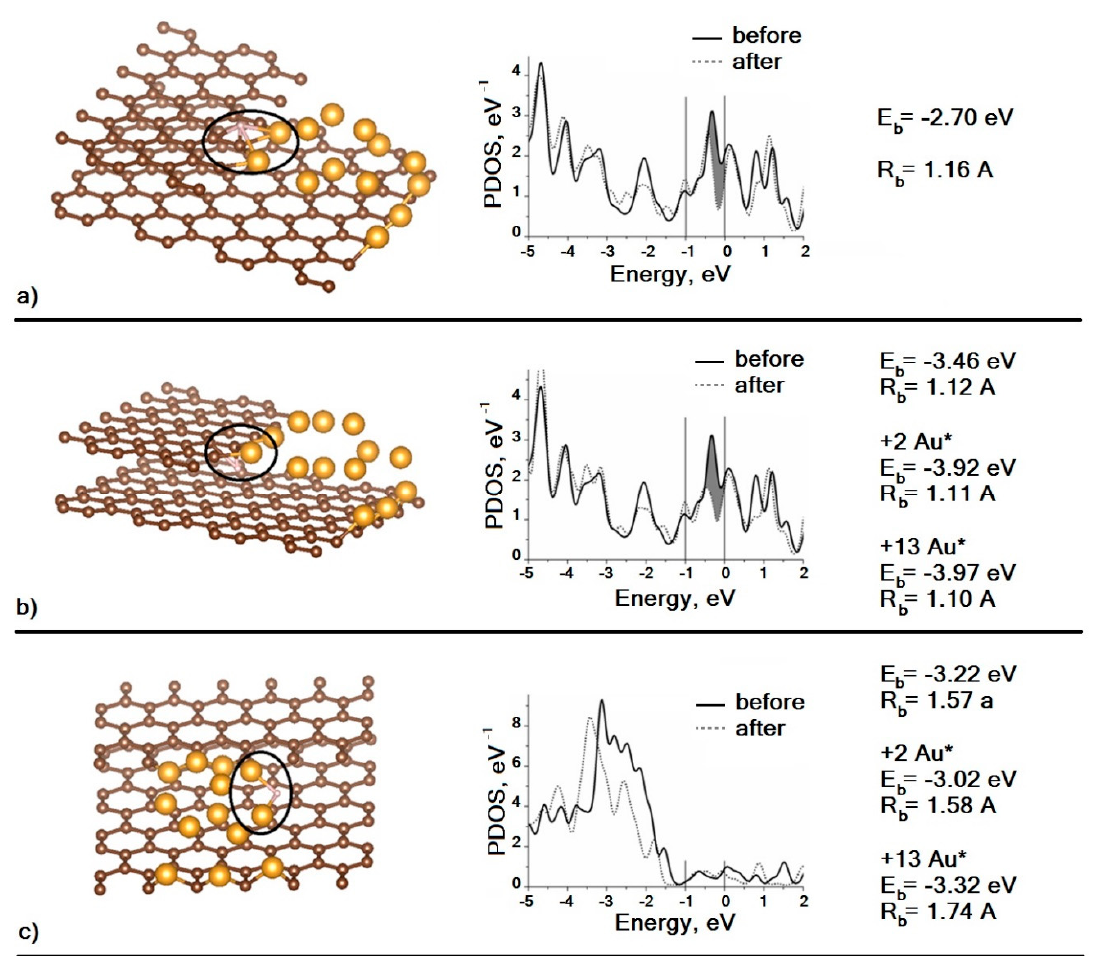
Figure 6. The projected density of electron states for various active centers in the supercluster Au 13 C 138 : ( a ) adsorption over the Au–C interface; ( b ) adsorption under the Au–C interface; ( c ) adsorption at the top of the Au 13 cluster. The cases of various numbers of mobile gold atoms are marked as “ + 2 Au*” and “ + 13 Au*”.